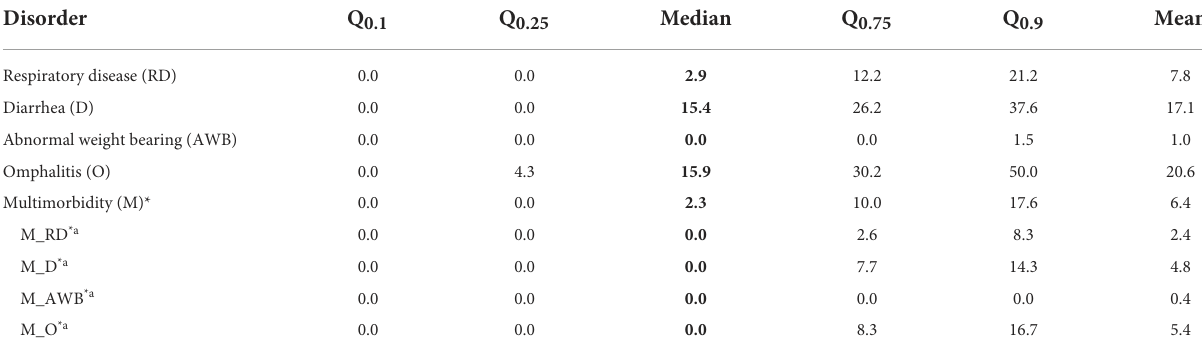
TABLE 7 Herd prevalence of disorders in 13,658 preweaned calves on 730 German dairies. Disorder